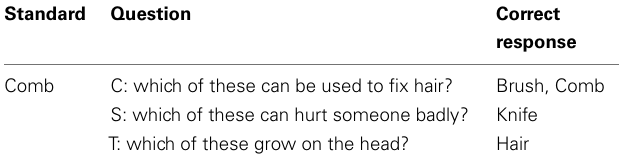
Table 3 | Mean proportion of each choice type and SD for Experiment 1, 2, and